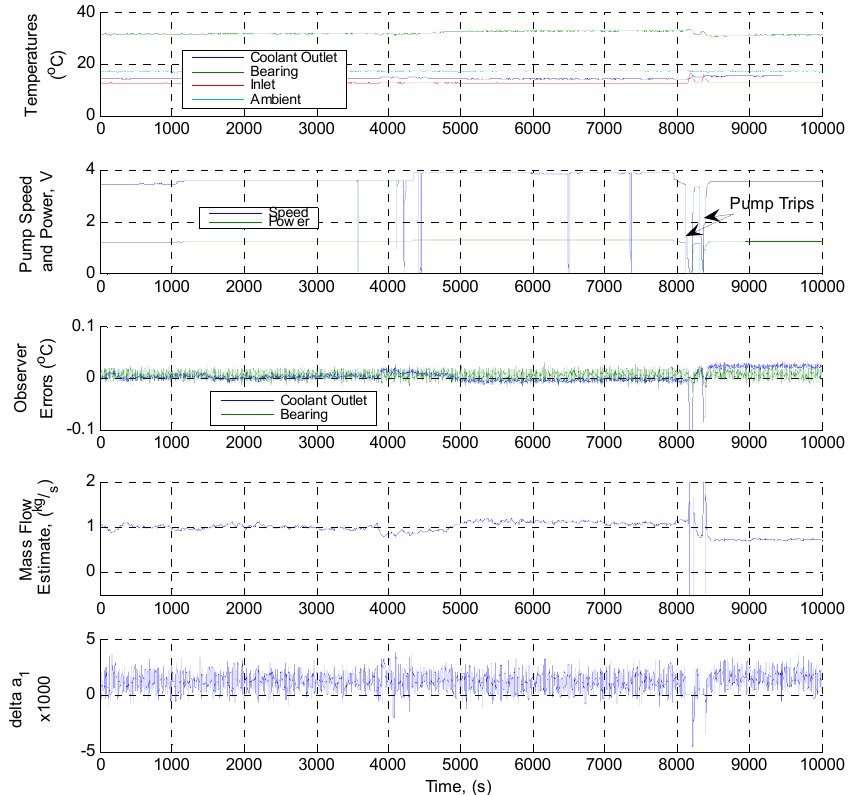
Figure 16. Online edge device implementation site trials results data: Pump 2 (variable speed).